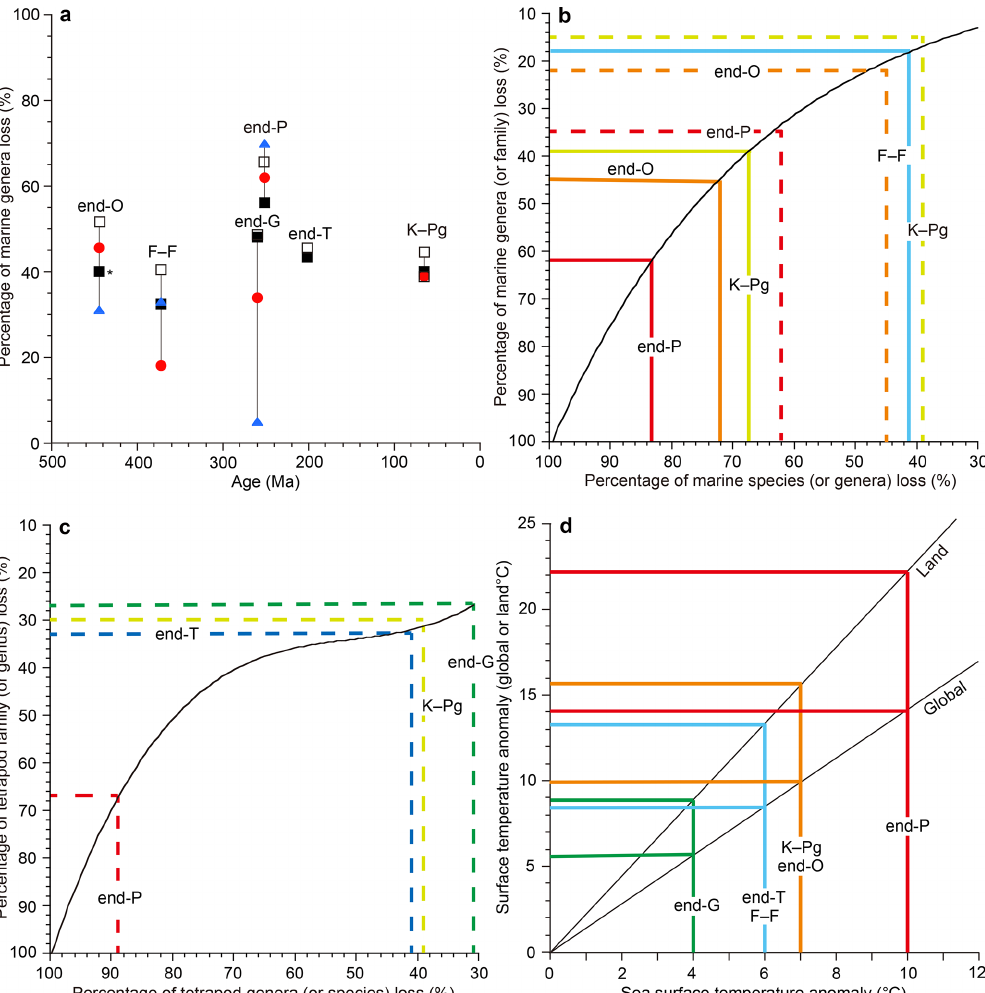
Figure 1. Marine genus loss (%) distribution (a) and relationship between extinction percentages of species, genera, and families ( b for marine invertebrates, c for terrestrial tetrapods) and between global surface temperature anomalies, land-surface temperature anomalies, and sea surface temperature (SST) anomalies (d) . Open square data from Sepkoski (1996), black square data from Bambach (2006), red circle data from Stanley (2016), and blue triangle data from Fan et al. (2020) in the graph (a) . Graphs (b, c) were used to convert extinction percentages among species, genera, and families. Dashed lines show the genus–family loss relationship (b, c) . The black curve in (b) is based on Stanley (2016). Graph (d) is based on the model calculation data from Kaiho and Oshima (2017) and is used to convert between the global surface temperature anomaly, land-surface temperature anomaly (global mean), and SST anomaly (global mean). All data are from Table 1. O: Ordovician. F–F: Frasnian–Famennian boundary. P: Permian. T: Triassic. K–Pg: Cretaceous–Paleogene boundary. The ∗ signifies the largest extinction percentage in the Late Ordovician mass extinction